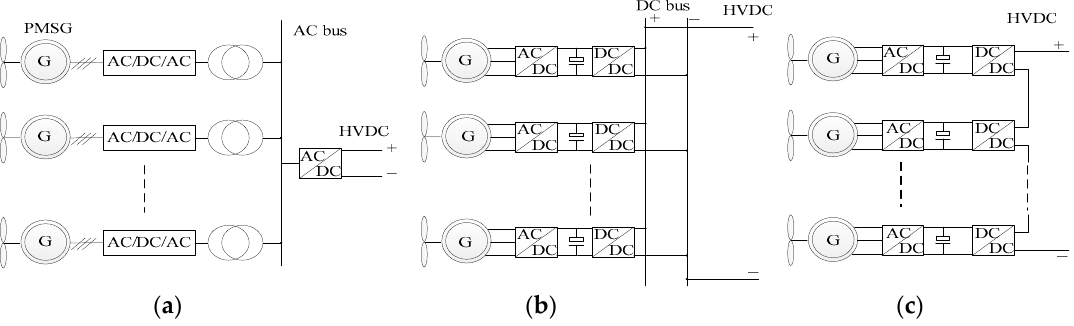
Figure 1. Topologies of traditional offshore wind farm: ( a ) Centralized rectifier; ( b ) DC power collection; ( c ) Series connected in DC side.